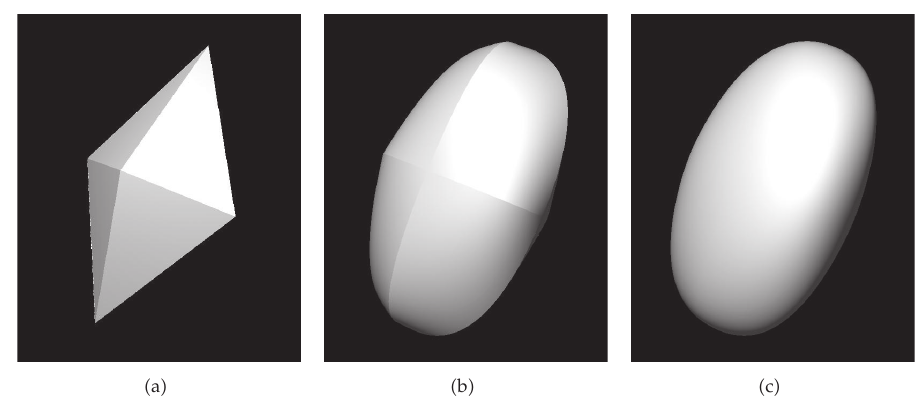
Figure 3: Application of the interpolation to a mesh of a smooth